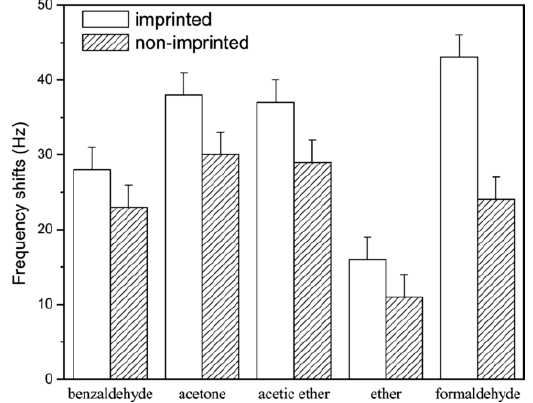
Figure 3. The resonance frequency response of the sensors to several analytes [24].